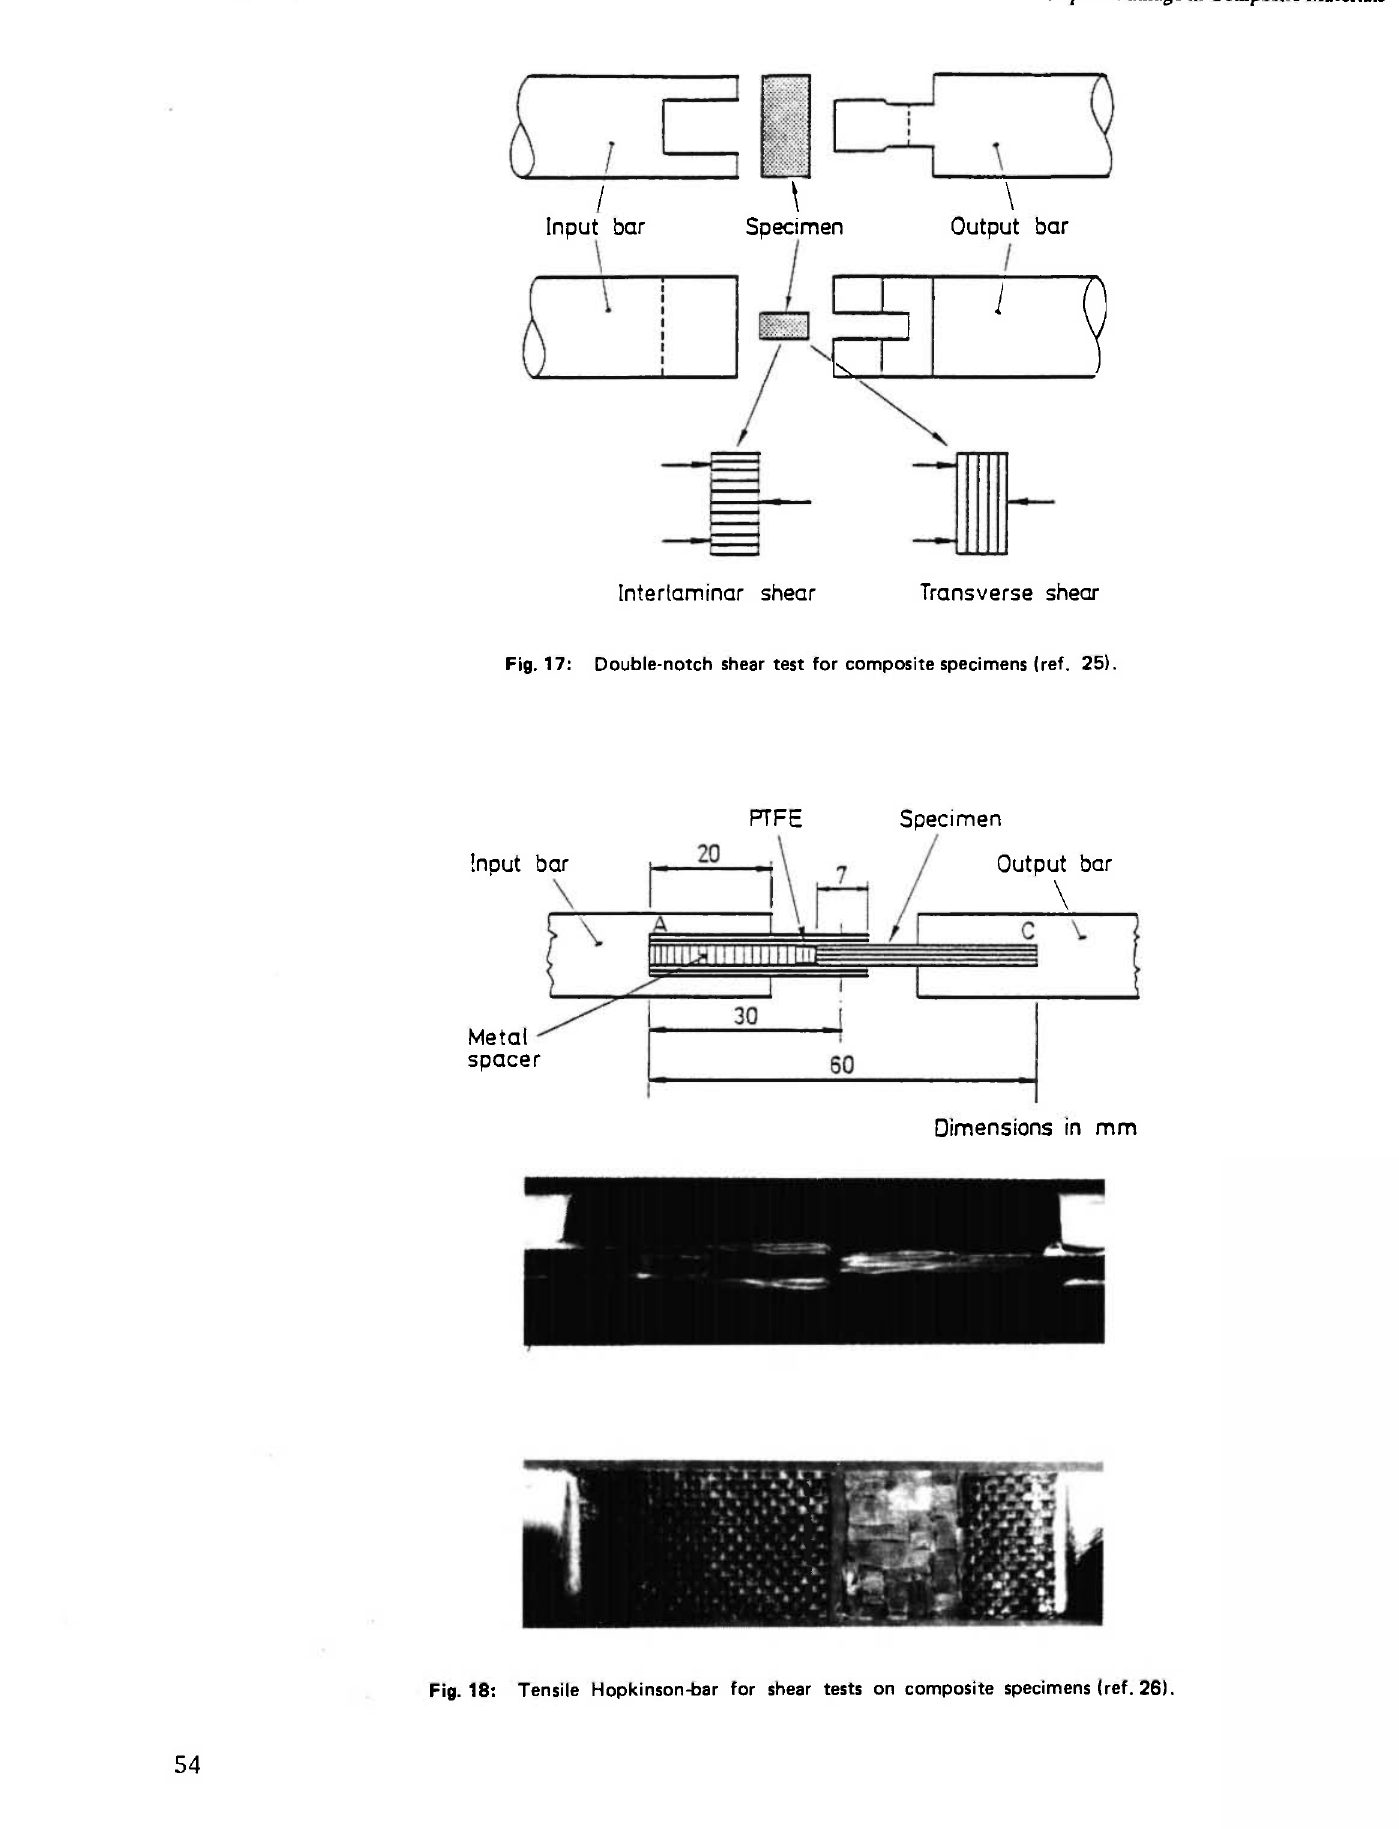
Fig. 17: Double-notch shear test for composite specimens (ref. 25).